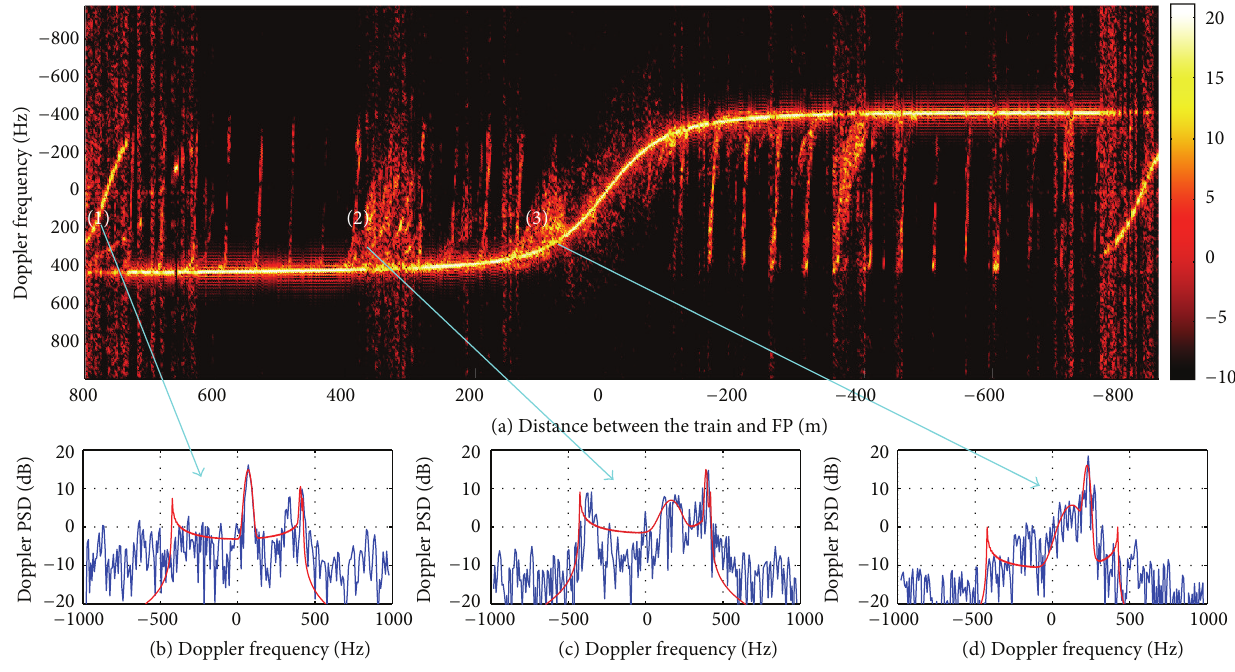
Figure 3: Doppler spectra characteristics in viaduct scenario.